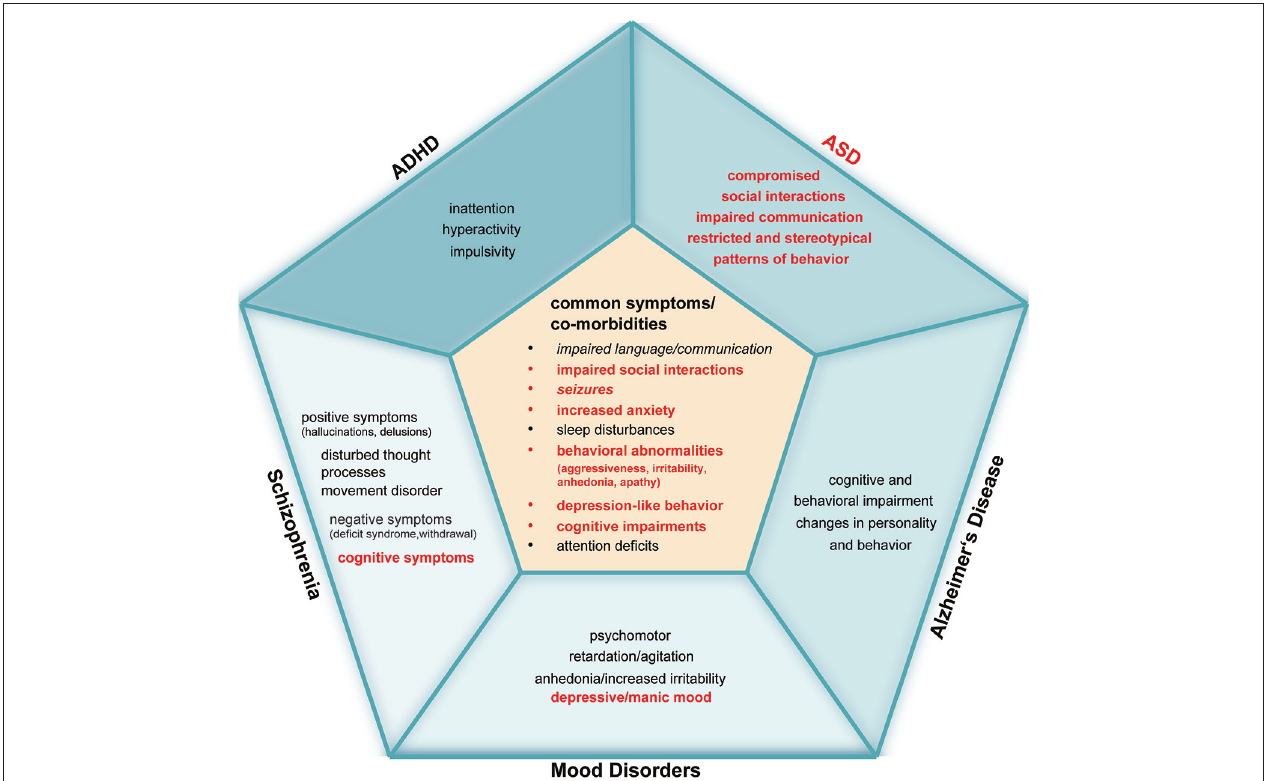
FIGURE 2 | Comparative overview of alterations reported in specific human diseases that share a behavioral pathology possibly associated with zinc deficiency . Zinc deficiency is commonly reported in ASD, ADHD, Alzheimer’s Disease (AD), Schizophrenia (SCZ), and Mood Disorders (MD). Symptoms and comorbidities labeled in red are known to be associated with zinc deficiency. The inner pentagon summarizes symptoms and co-morbidities that co-occur in ASD, ADHD, AD, SCZ and MD (symptoms and co-morbidities that are written in italic do not appear in all five disorders: language and communication problems have not been reported to occur in MD. ADHD or MD patients do not suffer from seizures more frequently compared to healthy controls). “Impaired language and communication” includes impaired language functions, absence, delayed or reduced speech, speech problems and talking in a dull or monotonous way. Unstable relationships, difficult peer relations, the loss of empathy, social